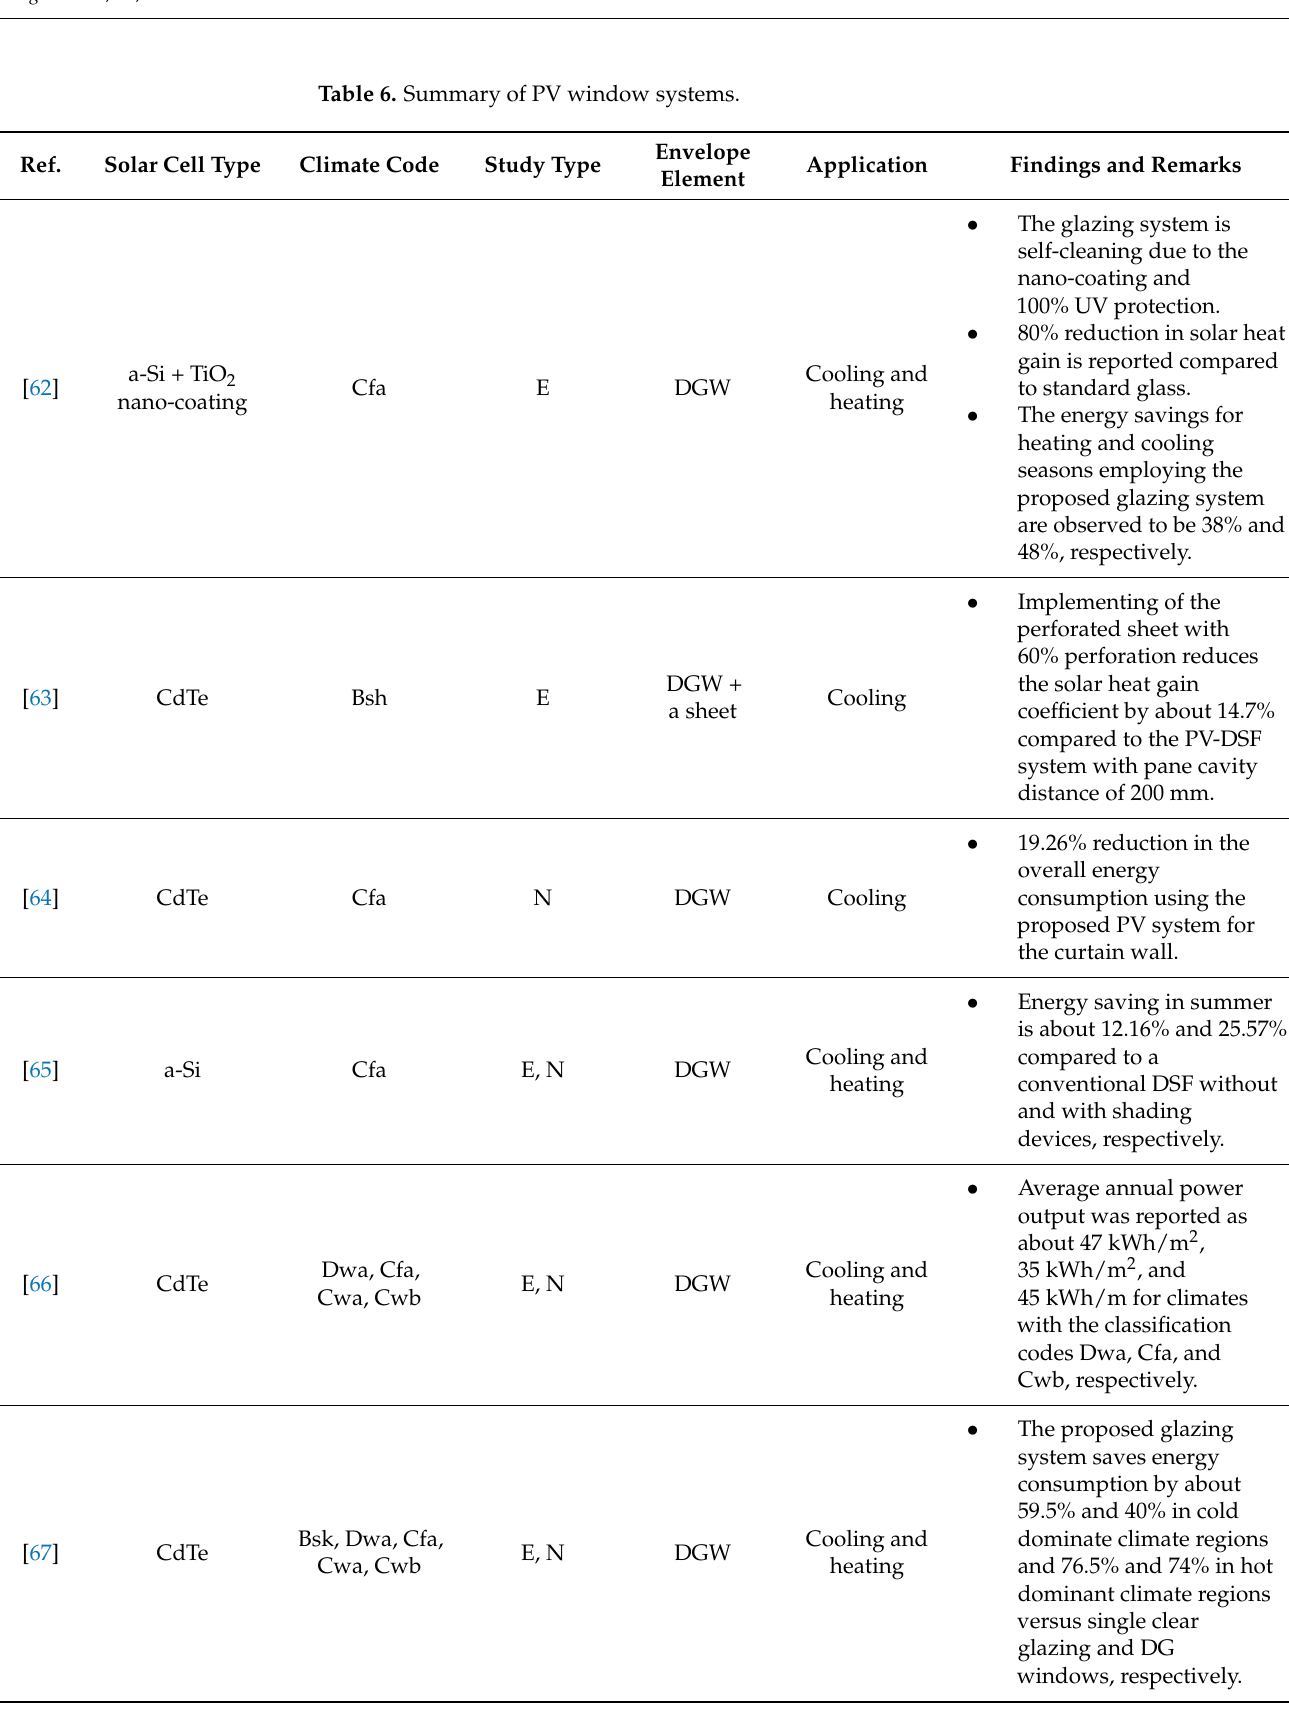
Table 6. Summary of PV window